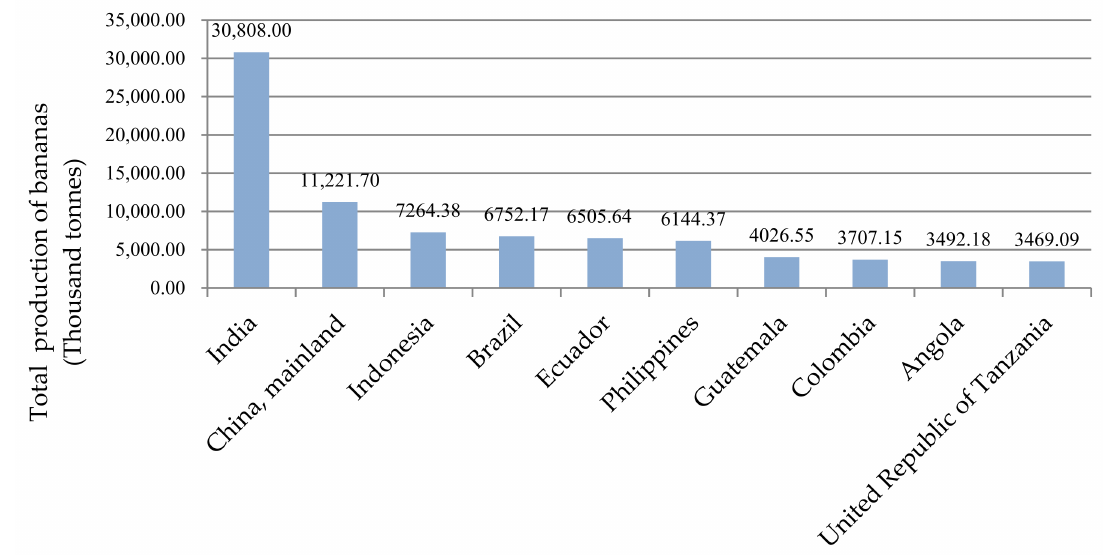
Figure 1. Top 10 banana producing countries by production in 2018. Source: Compiled from the data of FAO. Three provinces including Guangdong, Hainan and Yunnan are the dominant